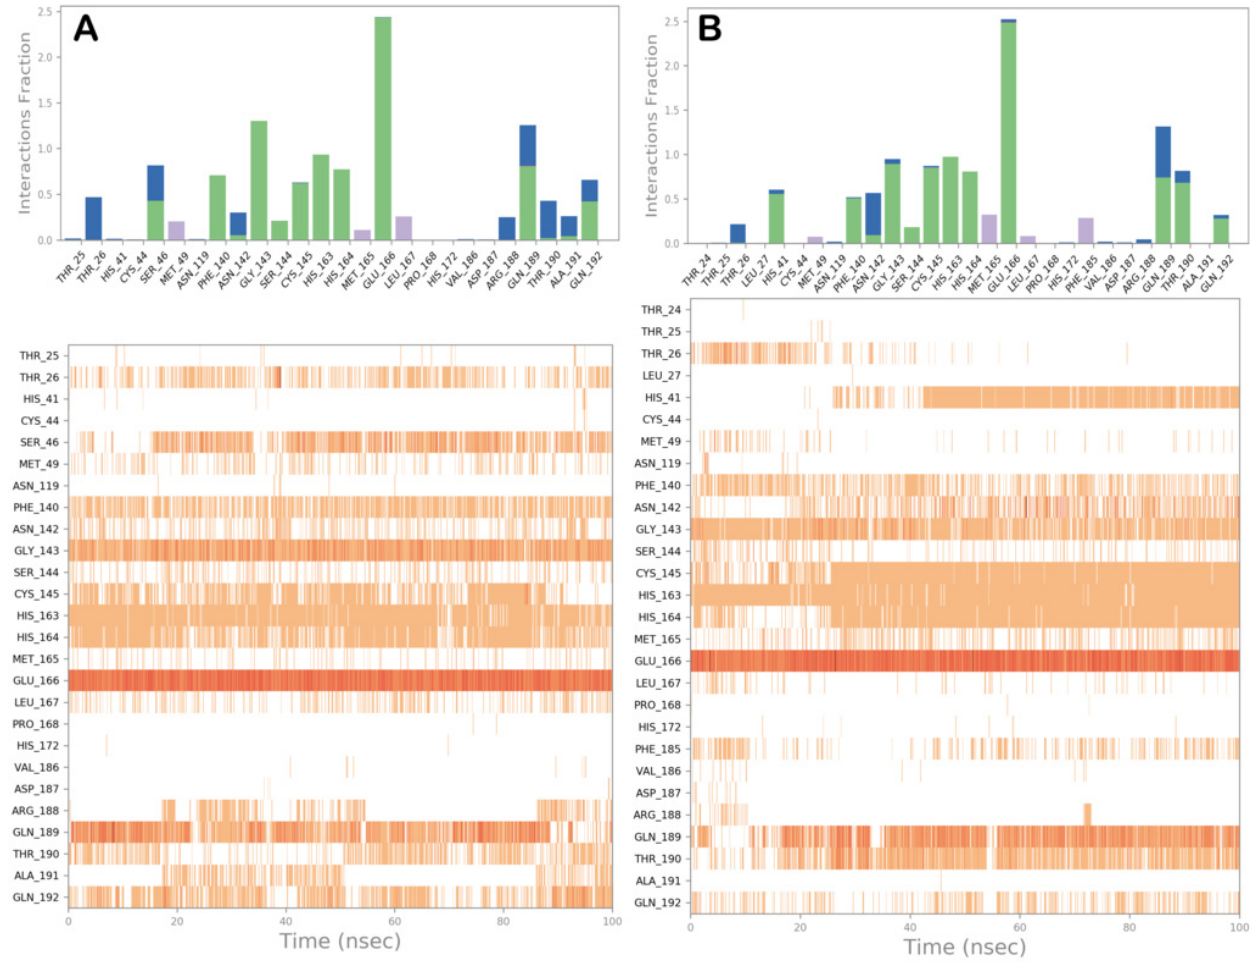
Figure 7. Compounds 4 (panel A ) and 5 (panel B ) monitored during the simulation. The contacts can be grouped by type and summarized, as shown in the plots. Grouping protein–ligand interactions into four types: H-bonds (green), hydrophobic (gray), ionic (magenta), and water bridges (blue). In the second graph of the picture is reported a timeline representation of the contacts. Some residues make more than one specific contact with the ligand, which is represented by a darker shade of orange. Pictures were generated by the simulation interaction diagram available in Desmond via Maestro (Maestro, Schrödinger LLC, release 2020-3).